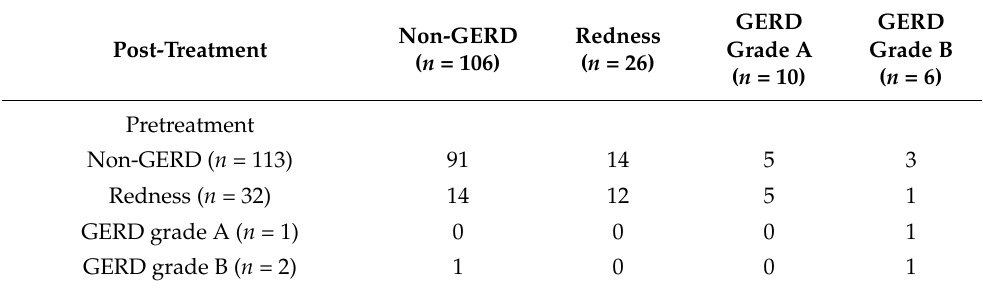
Table 3. Association of severity of GERD with pretreatment and after treatment